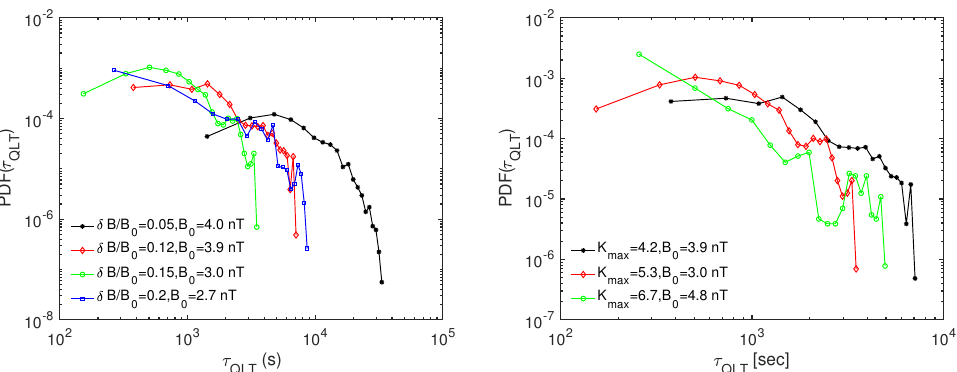
Figure 4. Probability density functions of the 100 keV energetic particles’ scattering times computed upstream of shock crossings with different levels of δ B / B 0 and similar intermittency ( left panel ) and with different intermittency values but a similar δ B / B 0 ( right panel